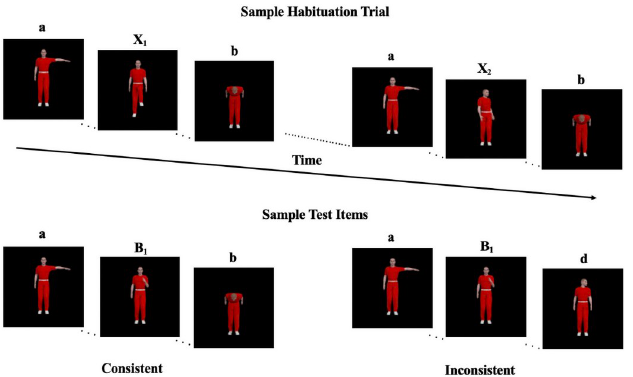
Fig 4. Examples of habituation materials and consistent vs. inconsistent test items in Experiment